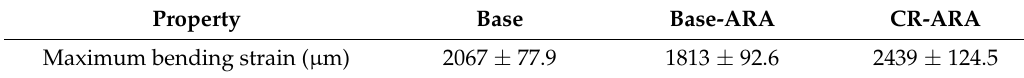
Figure 8. Plots of mid-cross deflection versus uniaxial loading of all specimens. Table 7. Maximum bending strain ( ε B ) of asphalt mix at − 10 ◦